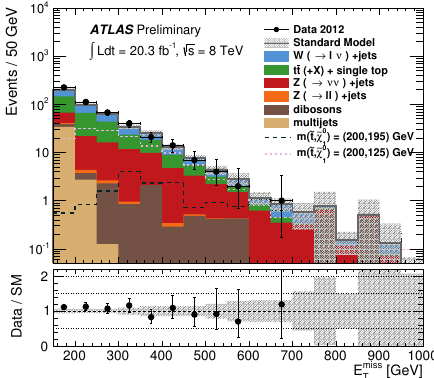
Figure 8: Measured E miss charm-tagged selection compared to the SM predictions.